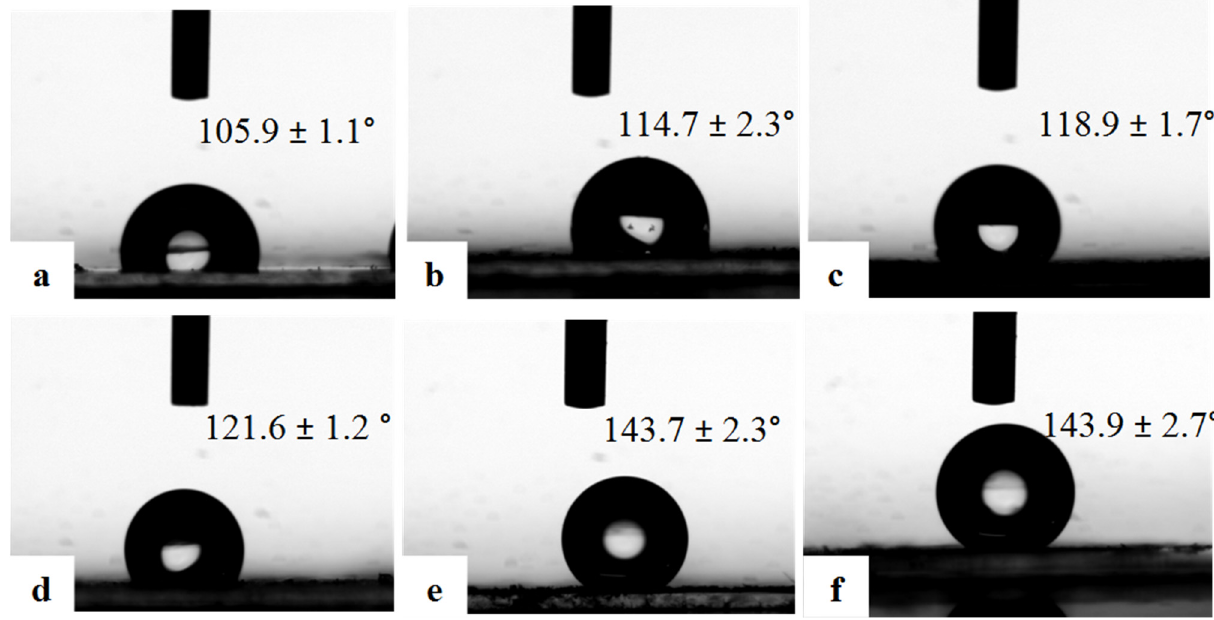
Figure 4. The water contact angle photos of the conductive polymer porous film prepared from different concentrations of the polymer solutions: ( a ) 0.08%; ( b ) 0.1%; ( c ) 0.2%; ( d ) 0.4%; ( e ) 0.6%; and ( f ) 0.8%.